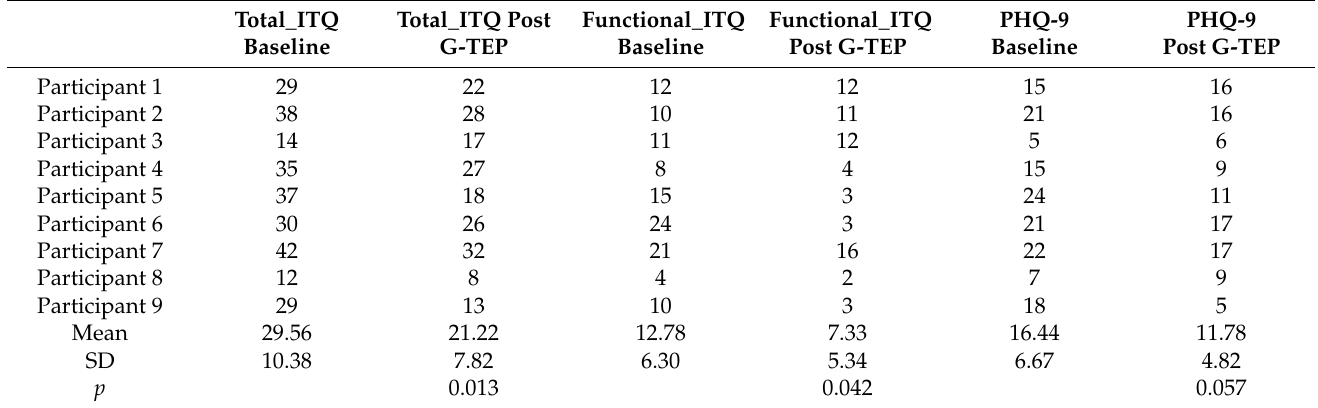
Table 2. Changes in symptoms of post-traumatic stress disorder (PTSD) and depression in participants receiving the 6-session Group Traumatic Event Protocol (G-TEP). p: Wilcoxon signed rank test; SD: standard